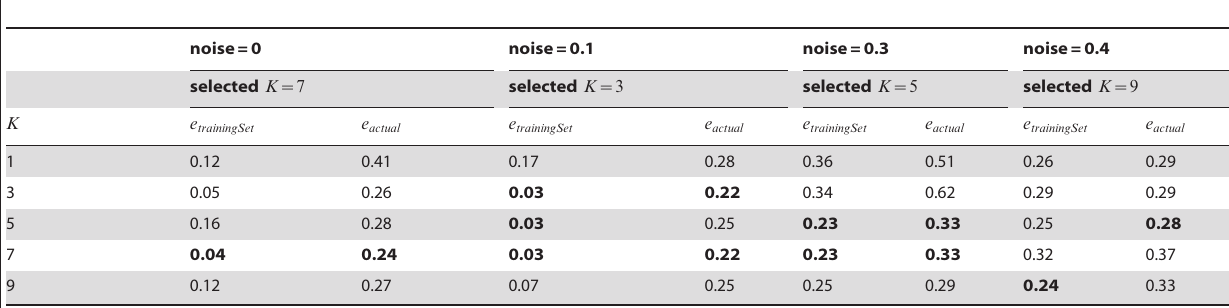
Table 2. Comparison of training error vs. actual error of a rule in model selection for different K values.